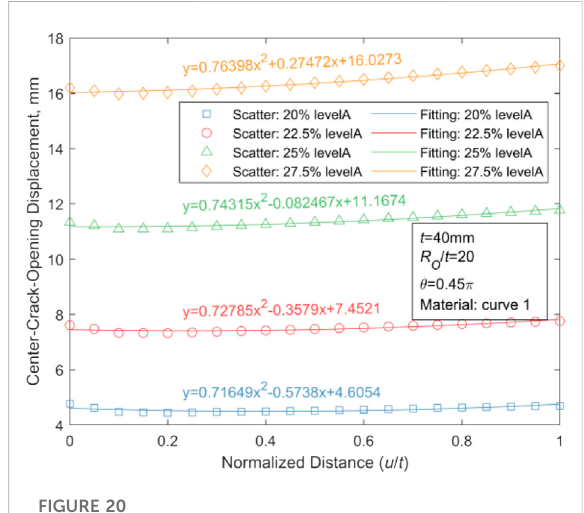
FIGURE 20 Fitting results of the axial displacement of the CTWC in thick- walled pipes.